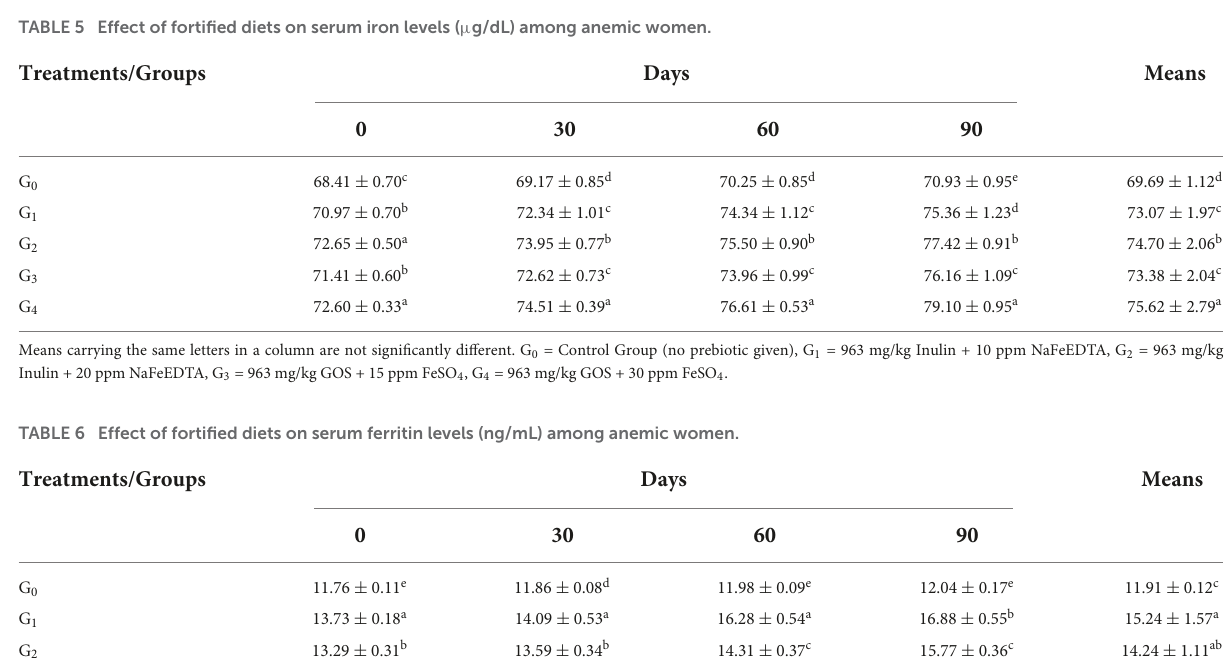
TABLE 5 Effect of fortified diets on serum iron levels ( µ g/dL) among anemic women. Treatments/Groups Days Means